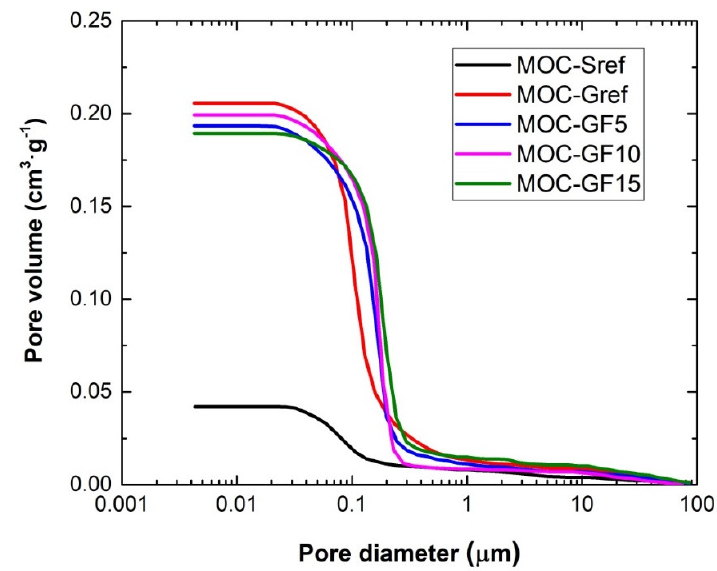
Figure 5. MIP cumulative pore volume curves.